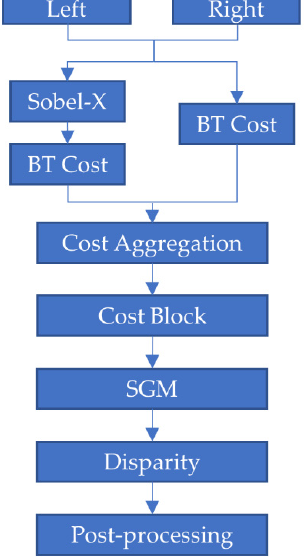
Figure 7. The flow of the SGBM algorithm.